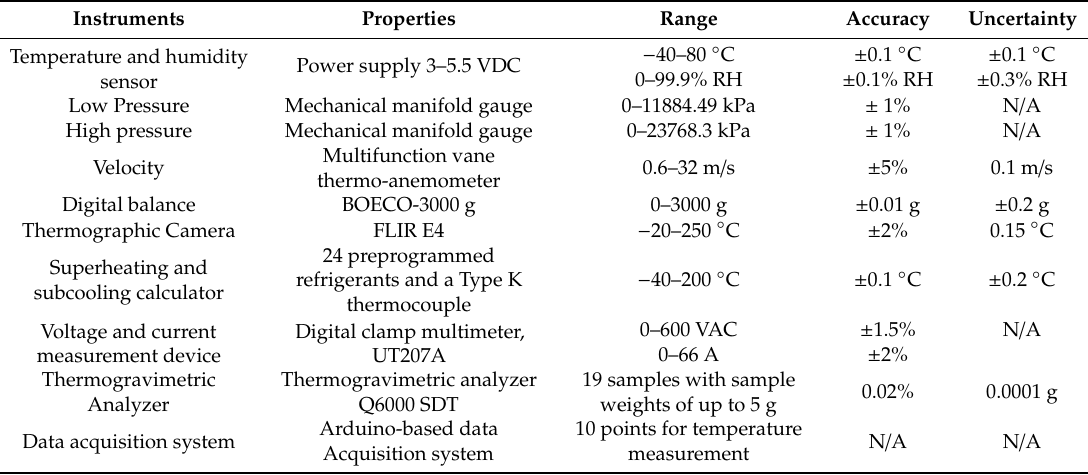
Table 2. Technical specifications of sensor and measurement devices.